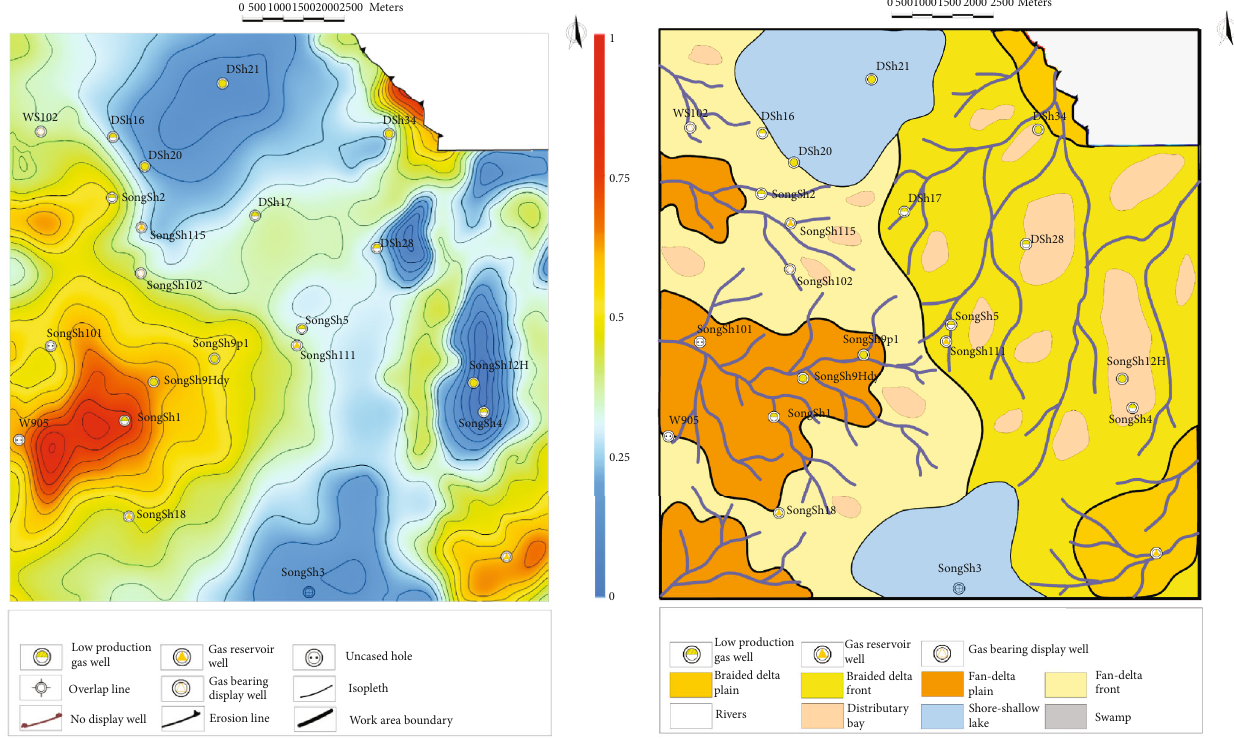
Figure 8: The sandstone percent map and sedimentary facies map of Sq4